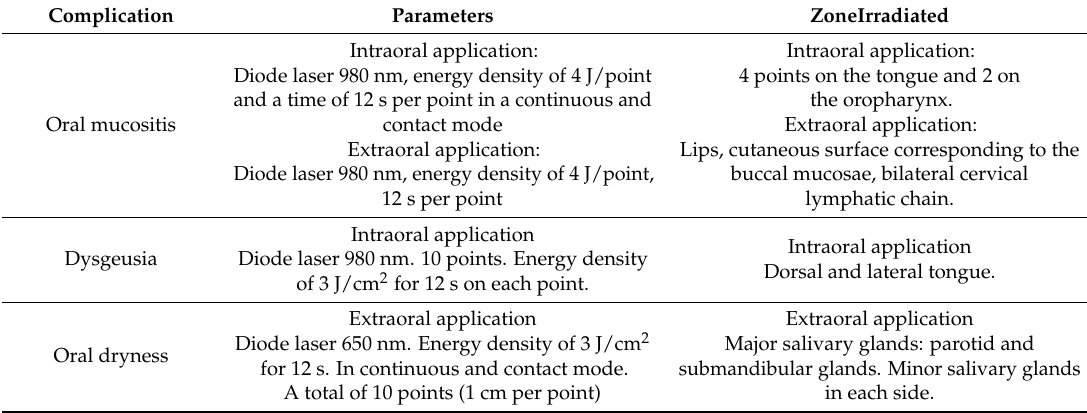
Table 2. Photobiomodulation parameters: applications and treatment